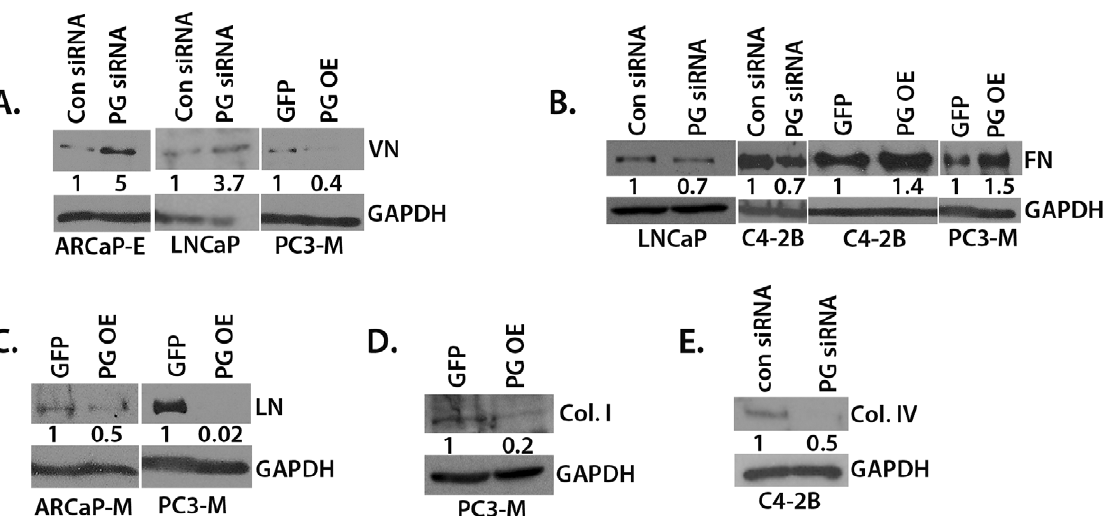
Figure 6. PG alters the profile of expression of ECM molecules in PCa cell lines. A–E. ARCaP E , ARCaP M , LNCaP, C4-2B, and PC3-M cells were plated in 6-well plates and allowed to attach and spread. The cells were either transduced with GFP- or PG-containing adenovirus and were lysed after 24 hours (PC3-M, C4-2B, ARCaP M ); or the cells were transfected with control siRNA or PG siRNA pool and after 96 hours lysed (ARCaP E , LNCaP, C4-2B). The lysates were subjected to SDS-PAGE followed by immunoblotting with antibodies against VN (A), FN (B), LN (C), Col. I (D), Col IV (E) and GAPDH. Levels of ECM proteins were determined by normalizing to GAPDH levels for each cell line using Image J. Representatives of at least three independent immunoblots are shown, with numbers representing GAPDH normalized PG siRNA/Con siRNA or PG OE/GFP ratio for the blot shown. The average ratio and standard deviation of GAPDH normalized PG siRNA/Con siRNA and PG OE/GFP is as follows: (A) ARCaP E 3.1 + / 2 1.3, LNCaP 2.0 + / 2 0.9, PC3-M 0.3 + / 2 0.1; (B) LNCaP 0.7 + / 2 0.05, C4-2B KD 0.8 + / 2 0.1, C4-2B OE 1.2 + / 2 0.2, PC3-M 1.5 + / 2 0.05; (C) ARCaP M 0.6 + / 2 0.1, PC3-M 0.4 + / 2 0.3; (D) 0.3 + / 2 0.1; (E) 0.4 + / 2 0.2.